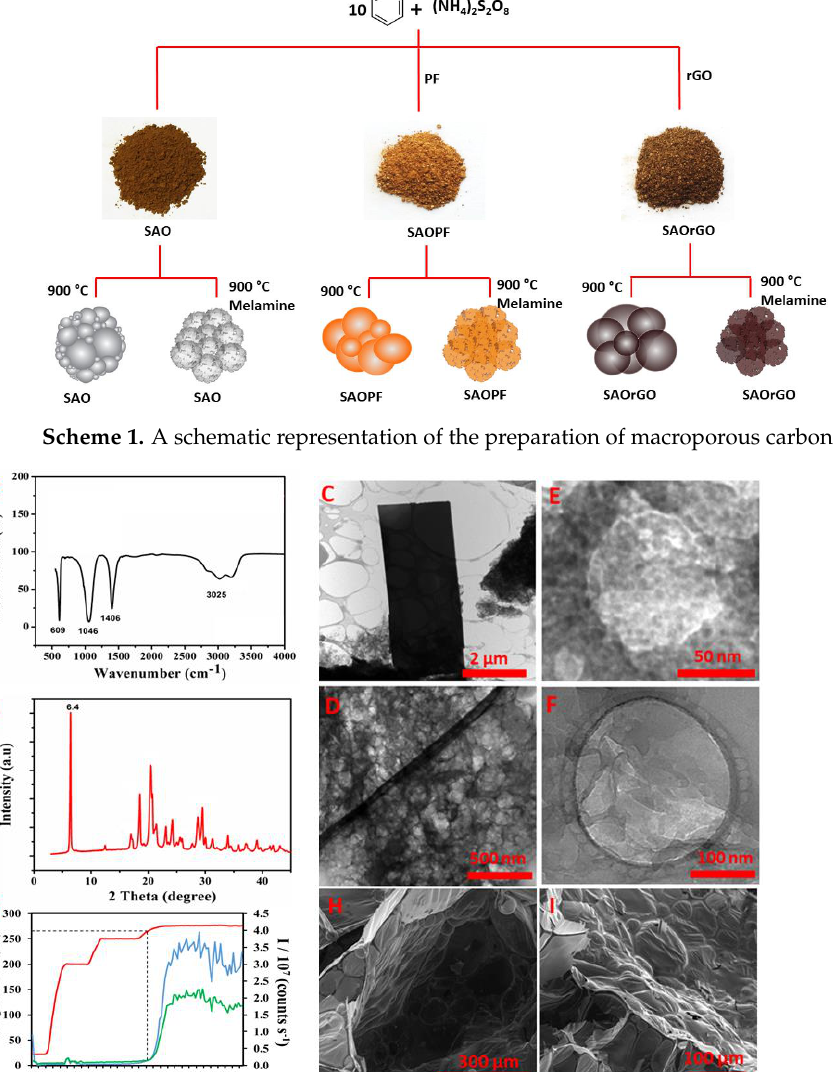
Scheme 2. Schematic procedure of synthesis of microporous carbon material (P-SAO) using SAO. ( A ) Synthesised SAO, SAO macroflakes, spherulites on the flake surface, single isolated spherulite, a schematic representation of a spherulite; ( B ) expansion of spherulites; ( C ) macroporous P-SAO.